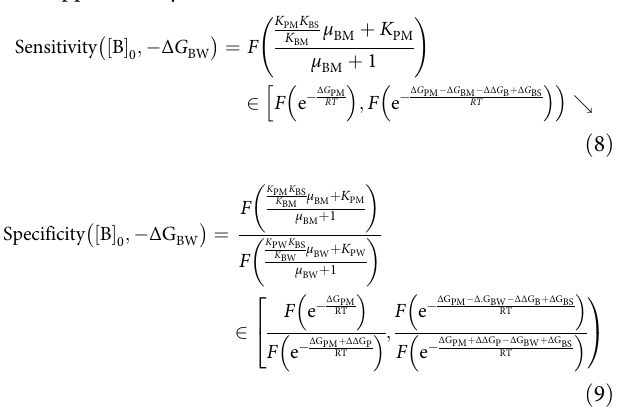
Fig. 1d, such deviations rendered the optimal detection zone predicted by approximated curves considerably de fl ected from that predicted by accurate curves. Moreover, the probe and the blocker could be double-stranded 38 – 42 , and the reactions between targeting strand and probe and blocker were via toehold mediated strand displacement (strand displacement probe/strand displace- ment blocker composition system). Modelling results in Supple- mentary Note 2 and Supplementary Fig. 1 showed that such system also possessed inverse correlation between sensitivity and speci fi city, and the de fl ection of approximated curves was even